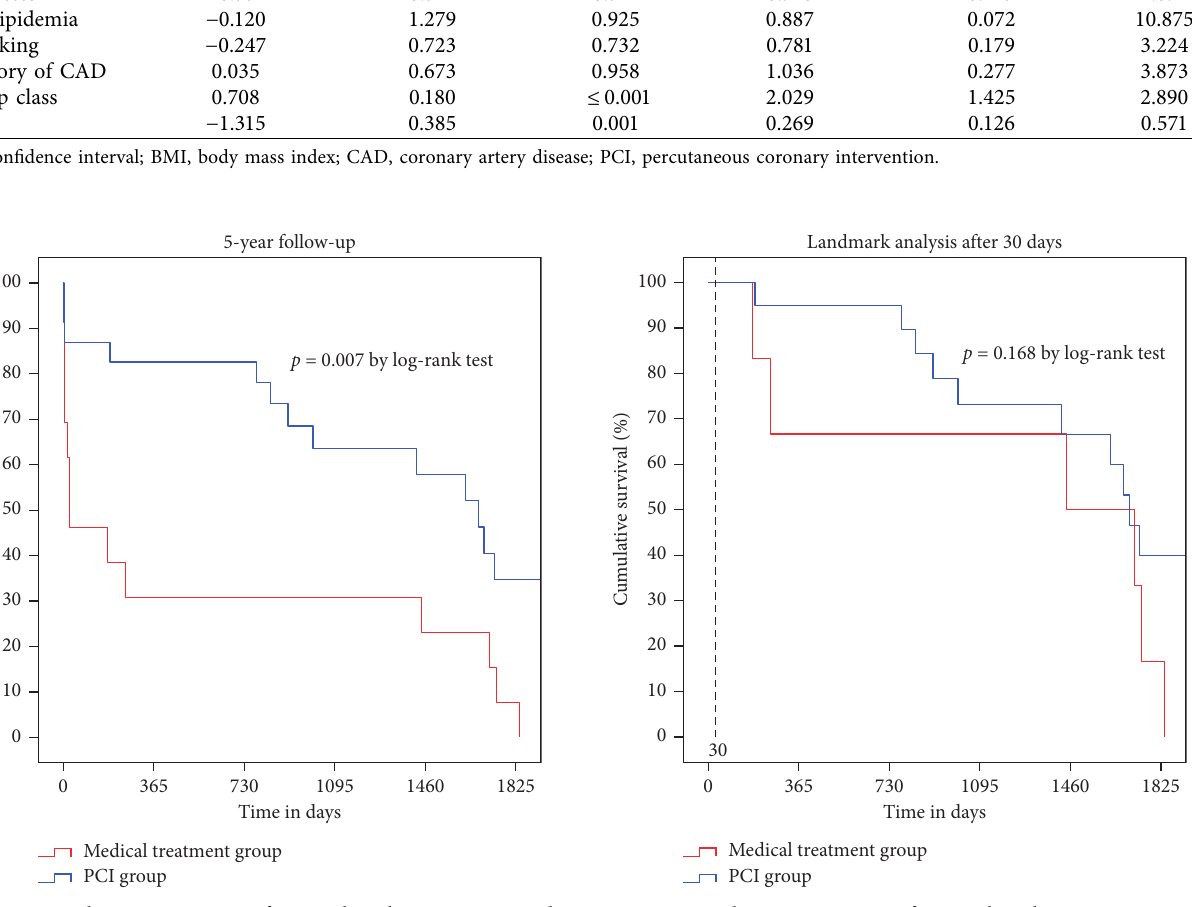
Figure 4: Kaplan–Meier curves of survival in the PCI group and medical treatment group after 30